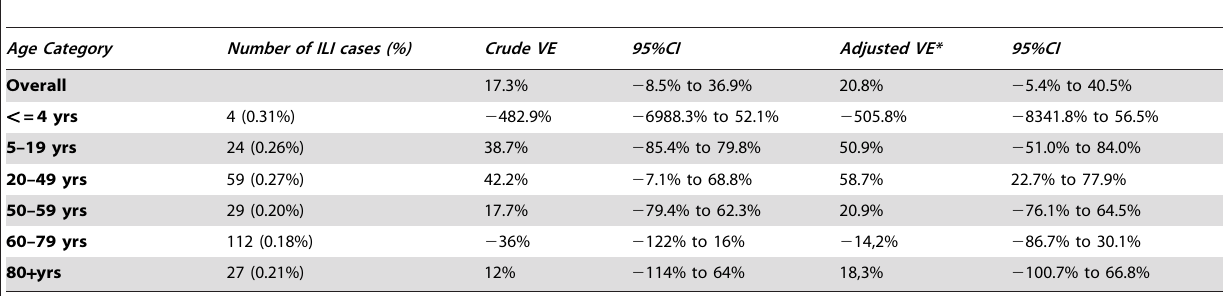
Table 3. Crude and adjusted pandemic H1N1 vaccine effectiveness per age category: Primary analysis with baseline at 30-11-2009 & Post hoc Time Dependent Analysis with baseline at